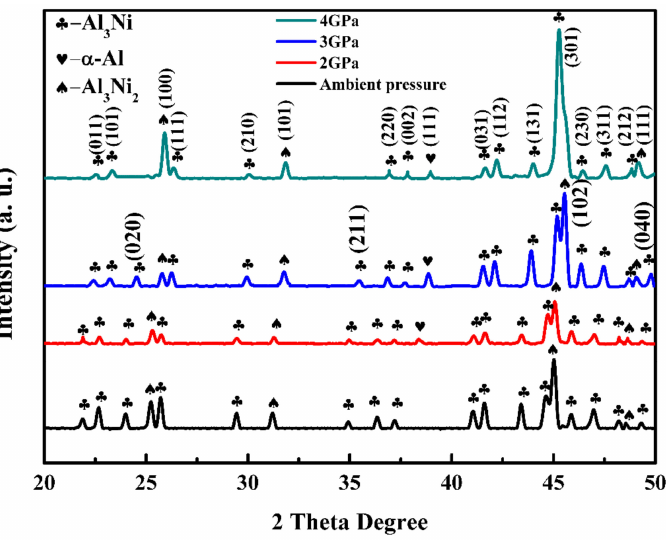
Figure 1. X-ray diffraction patterns of Al-47wt.%Ni alloy synthesized under different pressures. Based on the equilibrium phase diagram of Al-Ni alloy, the solidification of Al- 47wt.%Ni starts with the nucleation of AlNi phase from the metastable liquid. When cooling down to 1392 K, peritectic reaction L + AlNi → Al 3 Ni 2 will occur. When it